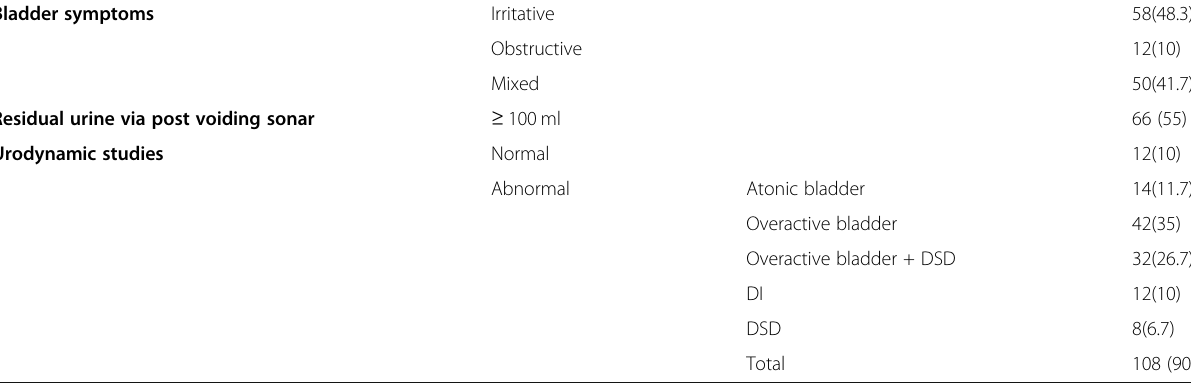
Table 2 Urological characteristics of multiple sclerosis Bladder